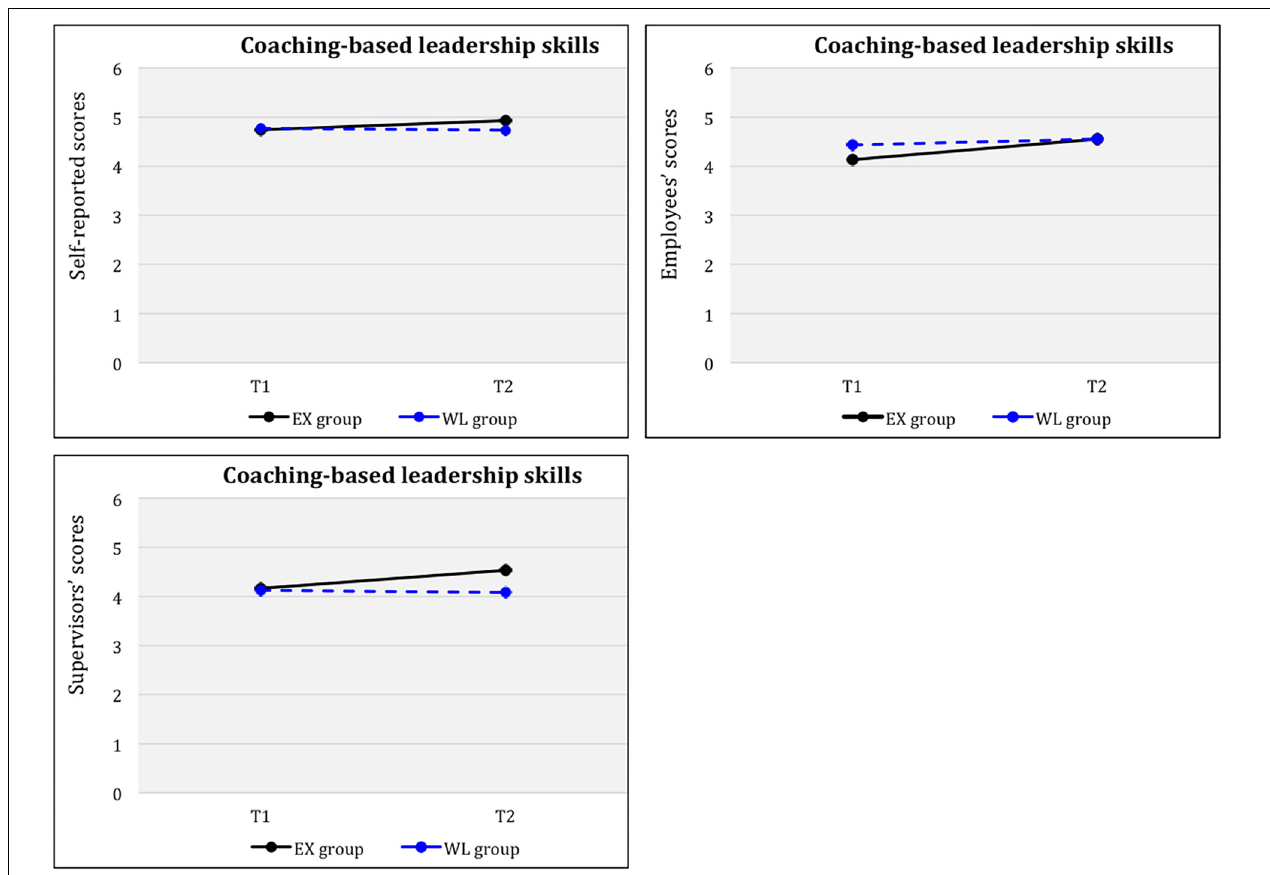
FIGURE 3 | Coaching-based leadership skills for groups (EX, WL) across time (Tl, T2).